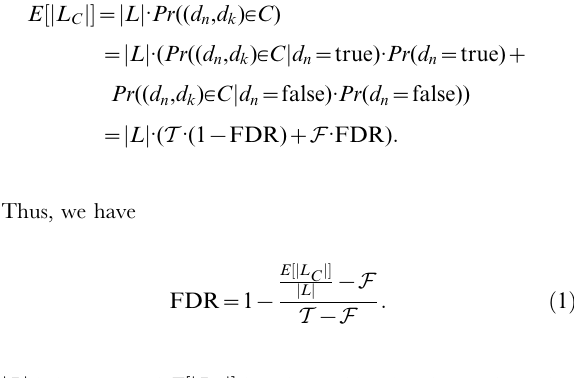
Figure S2 Sensitivity and accuracy of HHPRED + CODD and HMMER + CODD using the potential domain